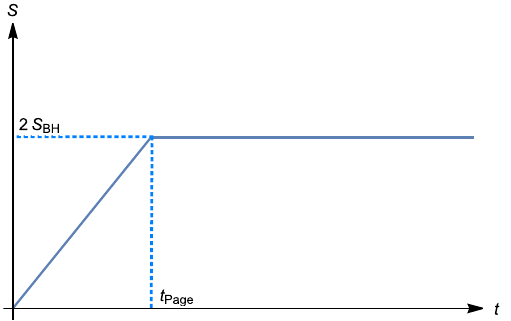
Fig. 2 Page curve. The entanglement entropy linearly increases at the early time. Then after the Page time, the entanglement entropy arrives at the maximum value – twice of the Bekenstein–Hawking entropy